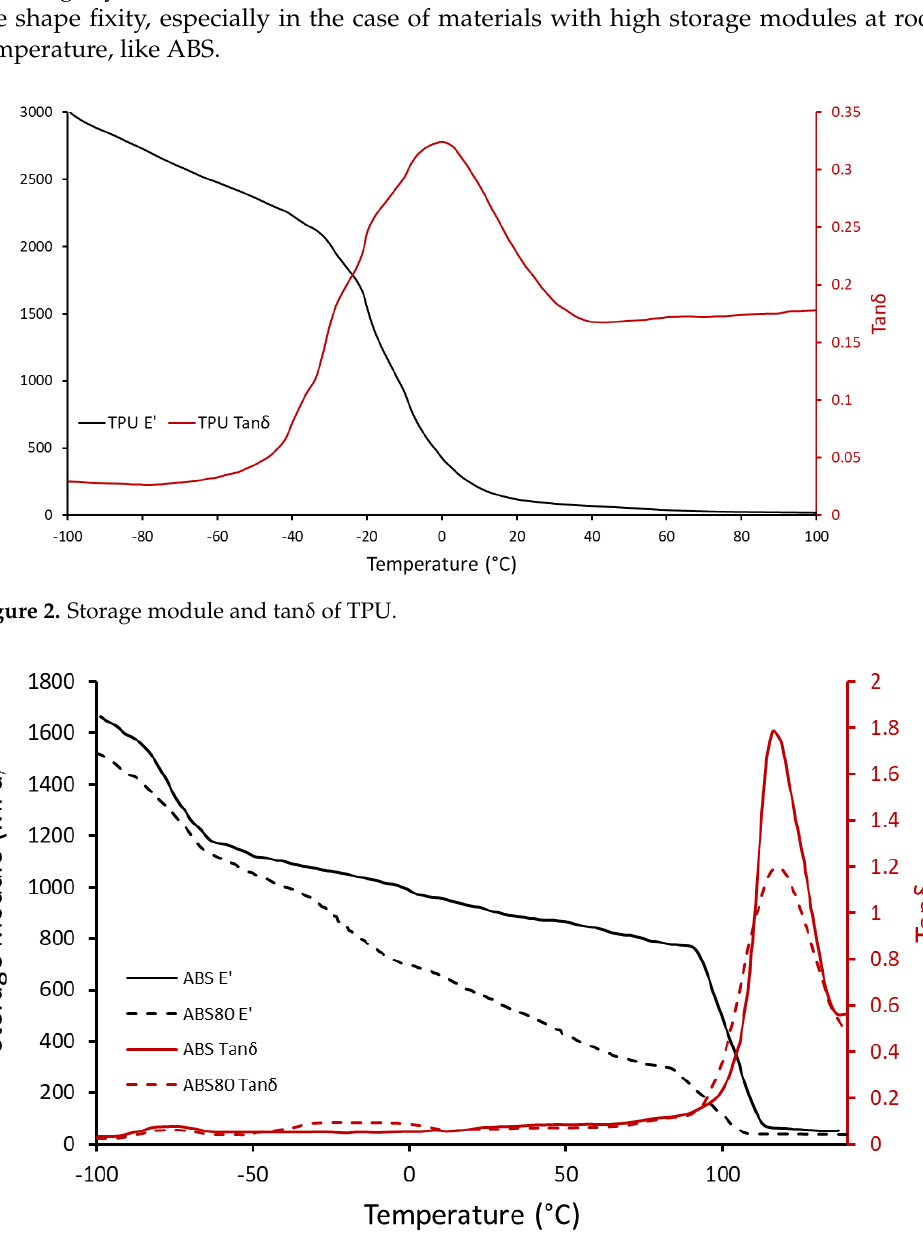
Figure 3. Storage module and tan δ of ABS and ABS80.